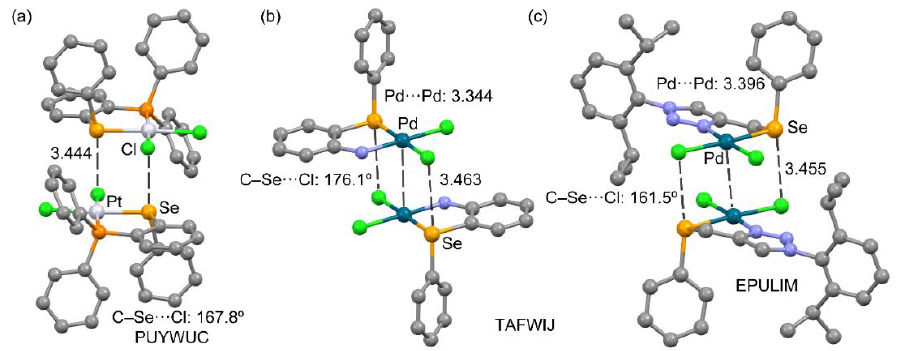
Figure 6. Partial views of the X-ray structures of PUYWUC ( a ), TAFWIJ ( b ) and EPULIM ( c ). Distances in Å. H-atoms omitted for